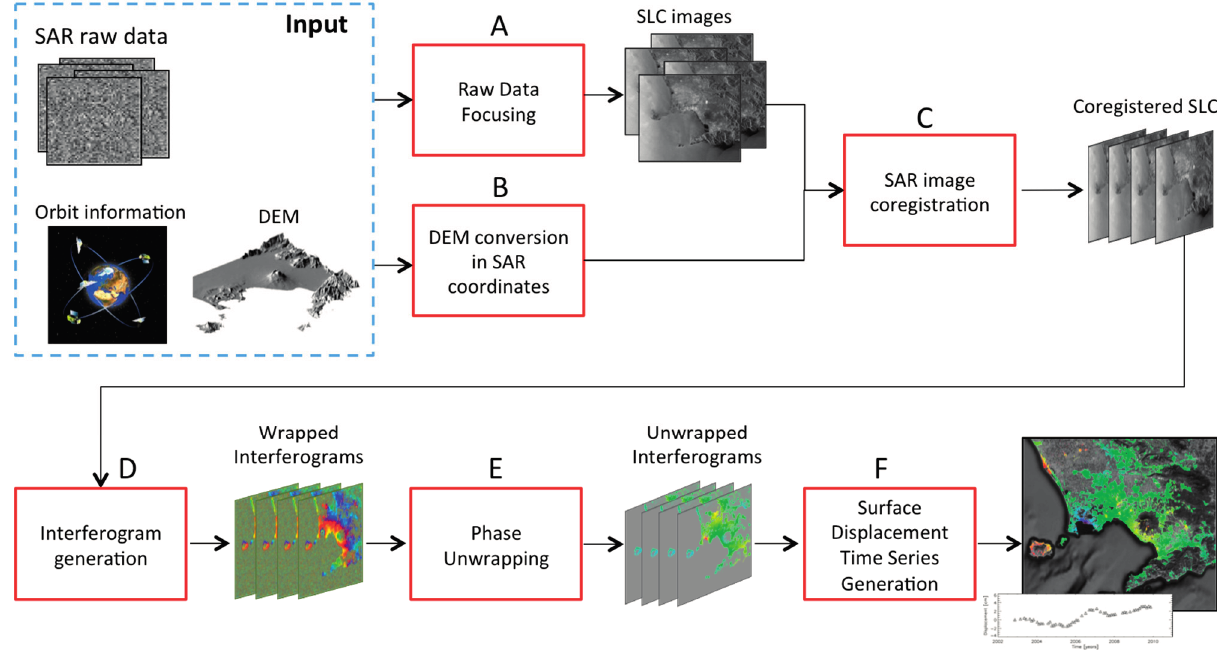
Figure 1. Simplified block diagram of the P-SBAS processing